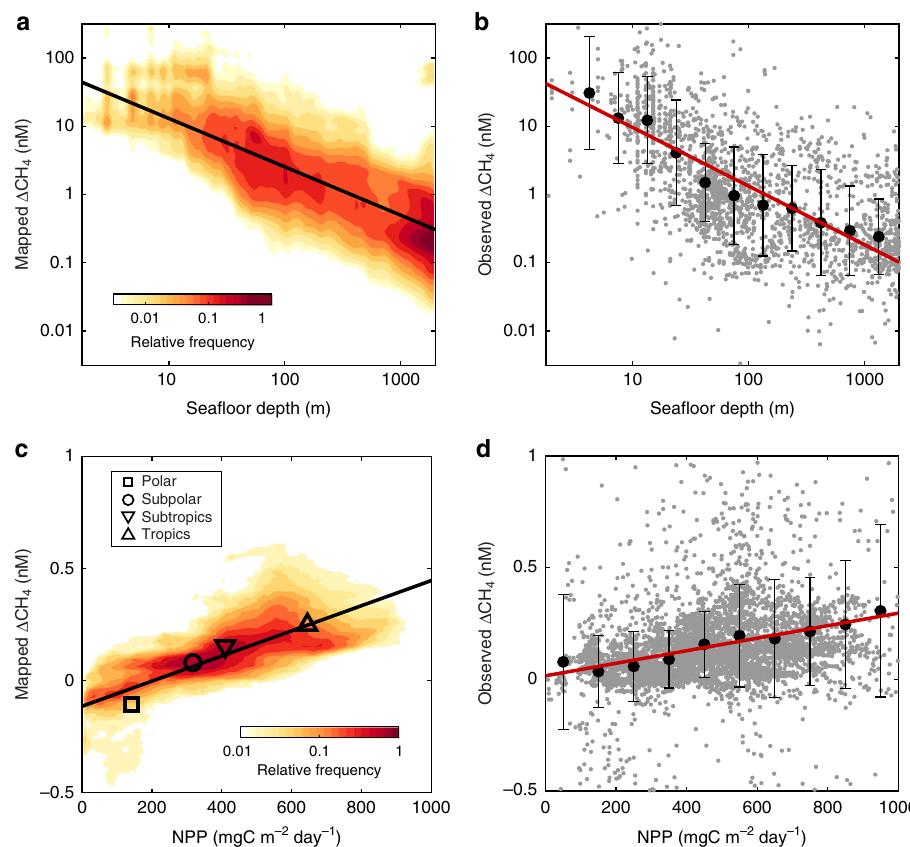
Fig. 6 Controls on surface ocean Δ CH 4 . a Joint probability distribution for mapped Δ CH 4 and sea fl oor depth ( z sf ) in coastal ocean regions (<2000 m depth). Color scale represents the frequency of gridcells with a given combination of log 10 (depth) and log 10 ( Δ CH 4 ), after averaging together all 200,000 machine-learning maps. Black line is the best fi t for the mapped data ( Δ CH 4 = 67 z sf − 0.7 , R 2 = 0.55). b Scatter plot of observed Δ CH 4 versus depth. Gray points show raw data; black circles with errorbars show mean ± s.d. Δ CH 4 within depth bins. Red line is best fi t to the binned data (CH 4 = 69 z sf − 0.8 , R 2 = 0.94). c , d Same as a and b , but for the relationship of mapped c and observed d Δ CH 4 to net primary production (NPP) in open ocean (>2000 m depth) environments. In c , black line is the best fi t for mapped data ( Δ CH 4 = (0.5NPP − 62)/10 3 , R 2 = 0.30), and symbols represent large-scale averages (Supplementary Fig. S8). In d , black circles show mean ± s.d. Δ CH 4 within NPP bins, and red line is best fi t to the binned data ( Δ CH 4 = (0.3NPP + 14)/10 3 , R 2 =